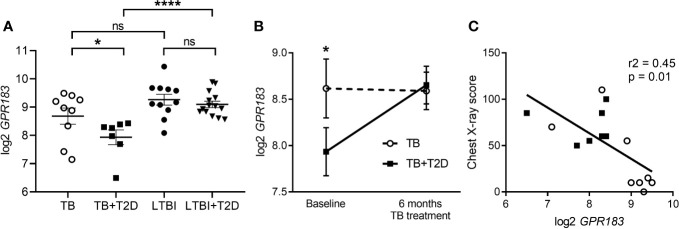
GPR183 mRNA expression in patients with active and latent TB infection with or without T2D. Total RNA was isolated from whole blood incubated overnight in QuantiFERON-TB Gold. GPR183 mRNA expression was determined and normalized to reference genes using the NanoString technology. GPR183 expression in whole blood of (A) TB (n = 9) and TB + T2D (n = 7) patients, LTBI (n = 11) and LTBI + T2D (n = 14) patients, Wilcoxon test. (B) TB (n = 9) and TB + T2D (n = 7) patients at baseline and 6 month’s treatment, t-test. (C) Correlation between GPR183 expression and chest x-ray score, TB + T2D patients (n = 7) filled squares, TB patients (n =8) open circles. Data are presented as means ± SEM; not significance (ns) P > 0.05; *P ≤ 0.05; ****P ≤ 0.0001.